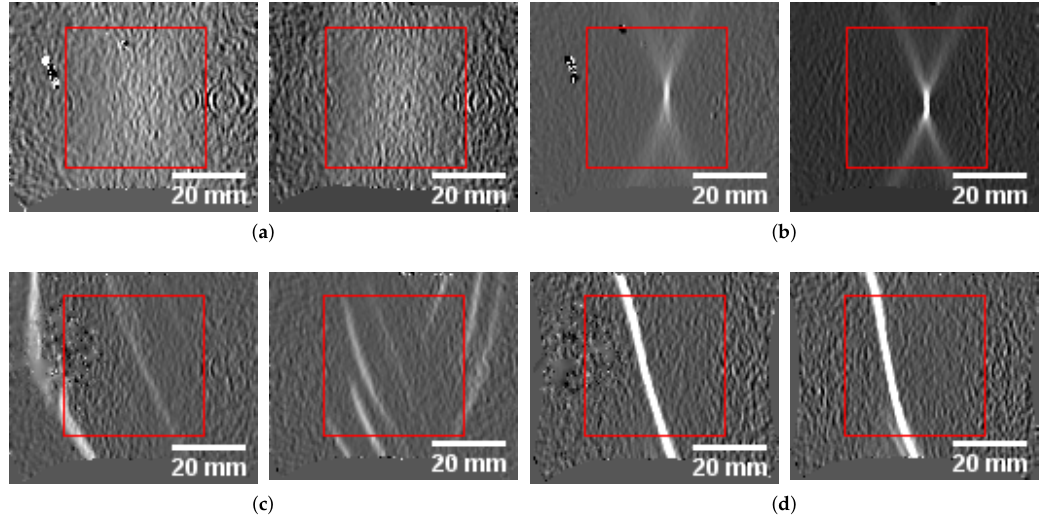
Figure 5. Comparison of homogeneous and localization phase cases of DP800-S050 and AA5182-S050: ( a ) DP800 homogeneous. ( b ) DP800 localization. ( c ) AA1582 homogeneous. ( d ) AA1582